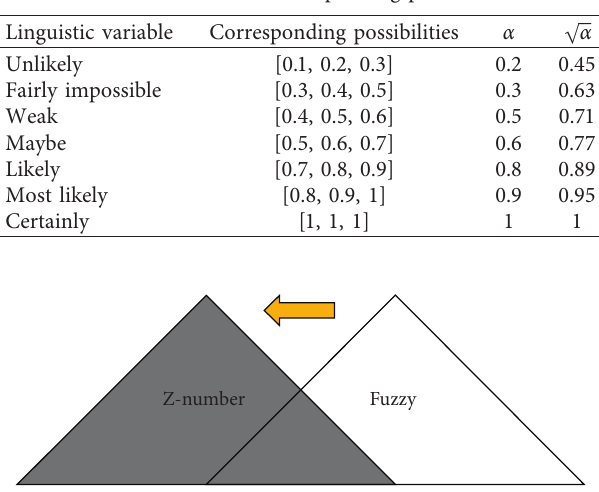
Figure 3: Compression between fuzzy and fuzzy Z-number